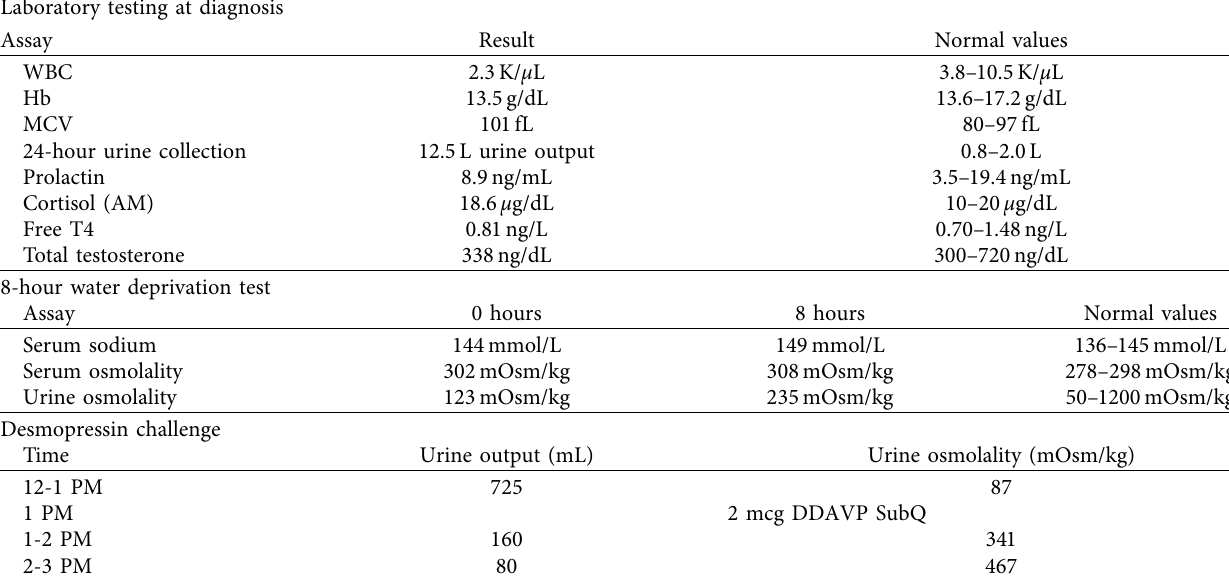
Table 1: Laboratory